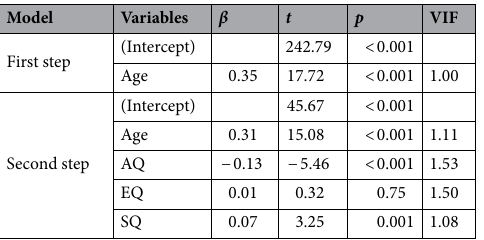
Table 7. Results for the multiple regression analysis for CSM in Survey 2.